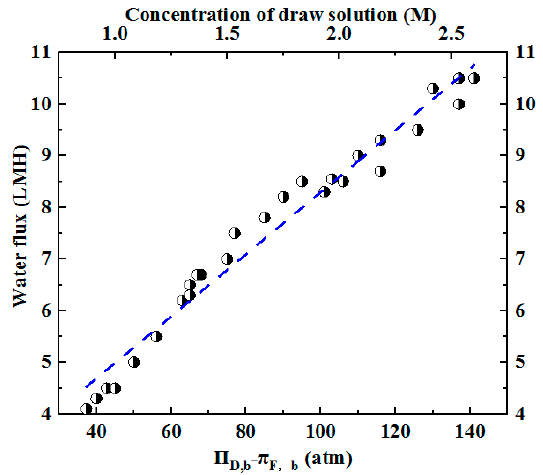
Figure 2. Osmotic water flux determined under diverse NaCl density (M) differences between the catholyte and anolyte (dotted line) based on linear Equation (3).